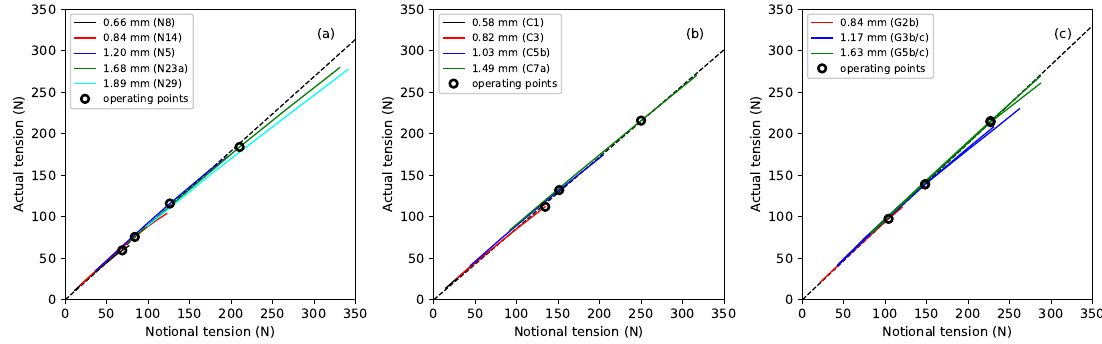
Figure 6. The measured tension of the strings versus the notional tension calculated using the unstretched linear density, for ( a ) nylon, ( b ) fluorocarbon, and ( c ) gut. Black circles show the results at the expected operating points. The dashed lines were fitted through these points and the origin for each